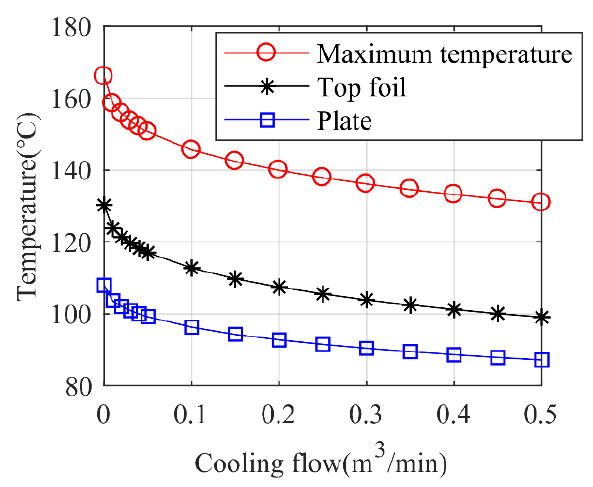
Figure 15. Relationship between bearing temperature and cooling gas flow.